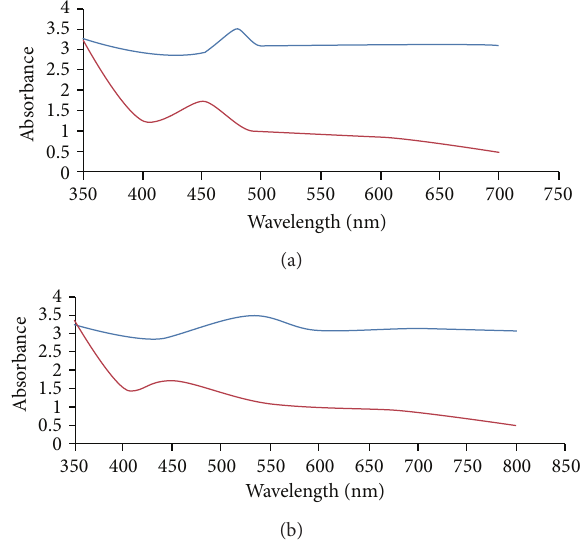
Figure 1: UV-Vis spectra of (a) silver nanoparticles and (b) gold nanoparticlessynthesizedbyusingthebarkextractof Cinnamomum zeylanicum recorded from reaction medium before (1) and after immersion of AgNO 3 (2) after